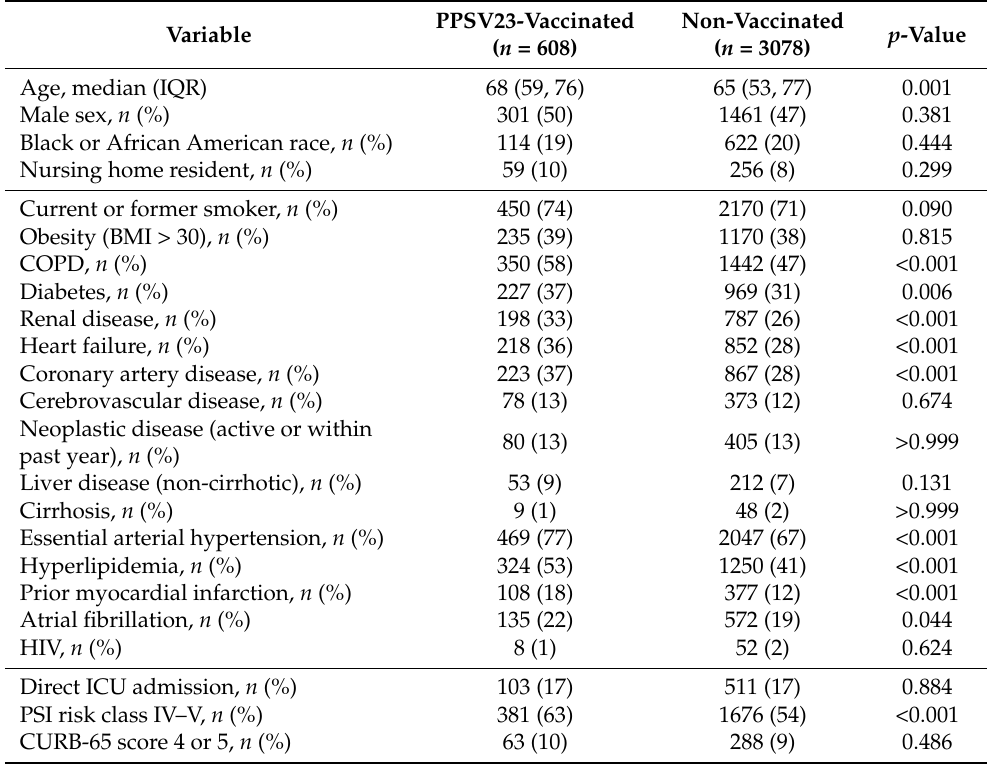
Table 1. Patient demographics, social and medical history between PPSV23-vaccinated and non- vaccinated CAP patients. PPSV23-Vaccinated Variable ( n =